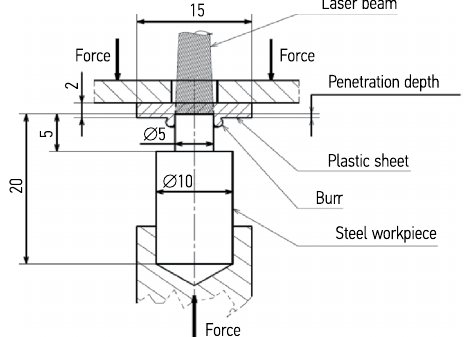
Fig. 1. Schematic view of the experimental setup